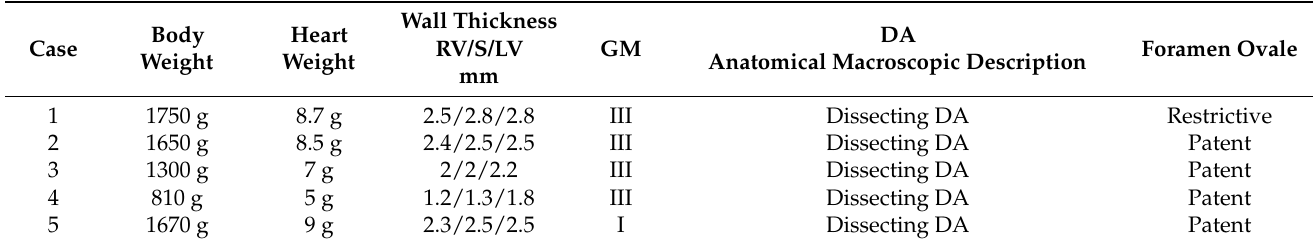
Table 2. Autopsy major